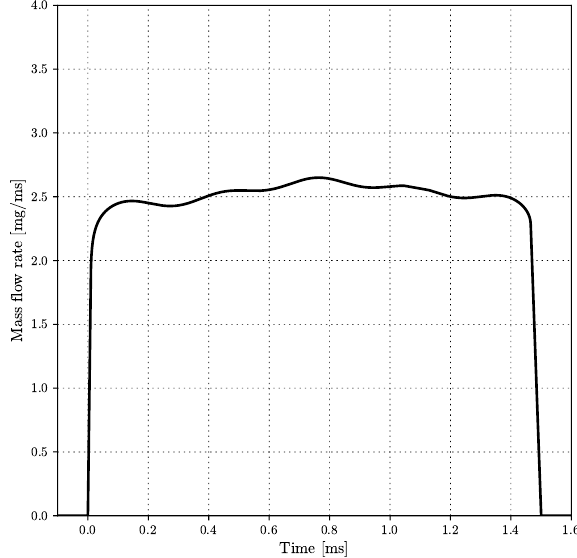
Figure 2. Employed rate of fuel injection [84].